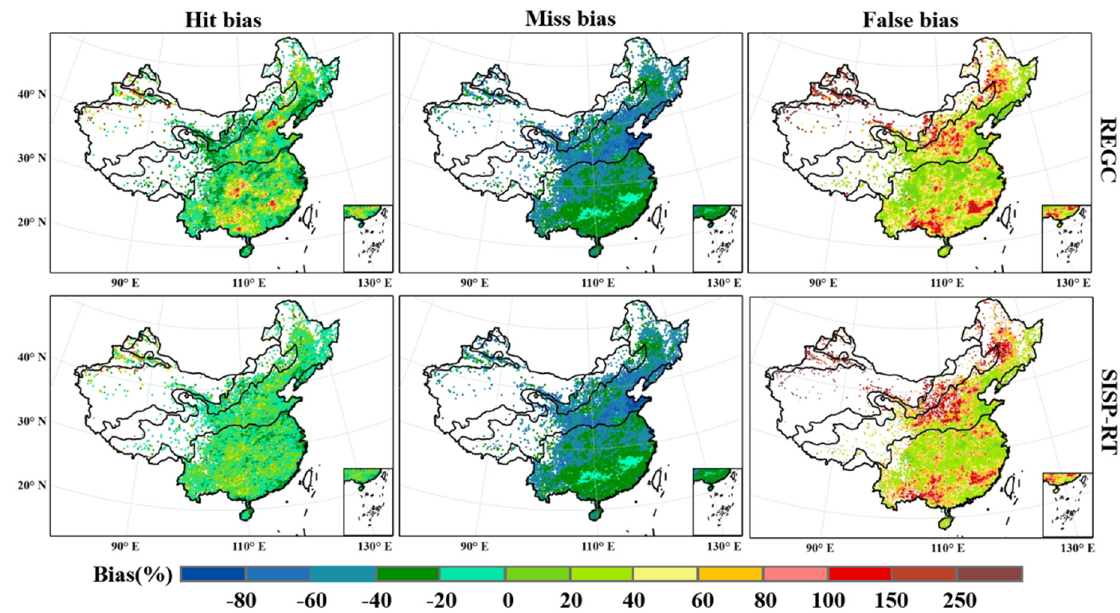
Figure 11. Spatial patterns of the three error components (i.e., hit bias (first column), miss bias (second column), false bias (third column)) for the REGC and SISP-RT at 0.1° spatial and hourly temporal resolution over mainland China in Jun–Aug 2019.